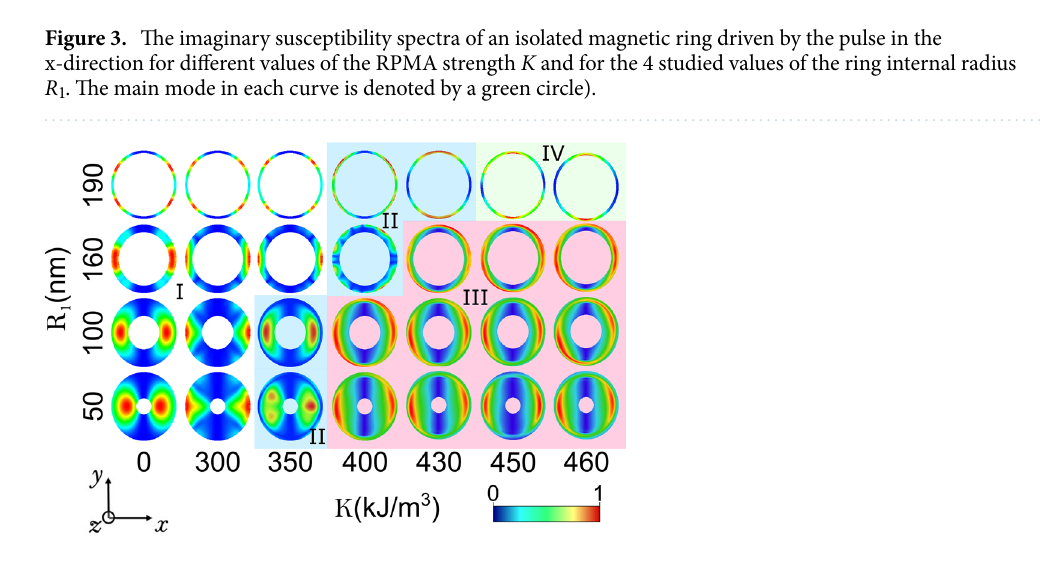
Figure 4. Main spatial modes of the magnetic nanoring driven by the pulse in the x-direction for different values of the RPMA strength K and for the 4 studied values of the ring internal radius R 1 . Region I (white background) correspond to vortex states. Region II (blue background) correspond to knot states. Region III (red background) correspond to meron states. Region IV (green background) correspond to uniformly magnetized nanoring in z